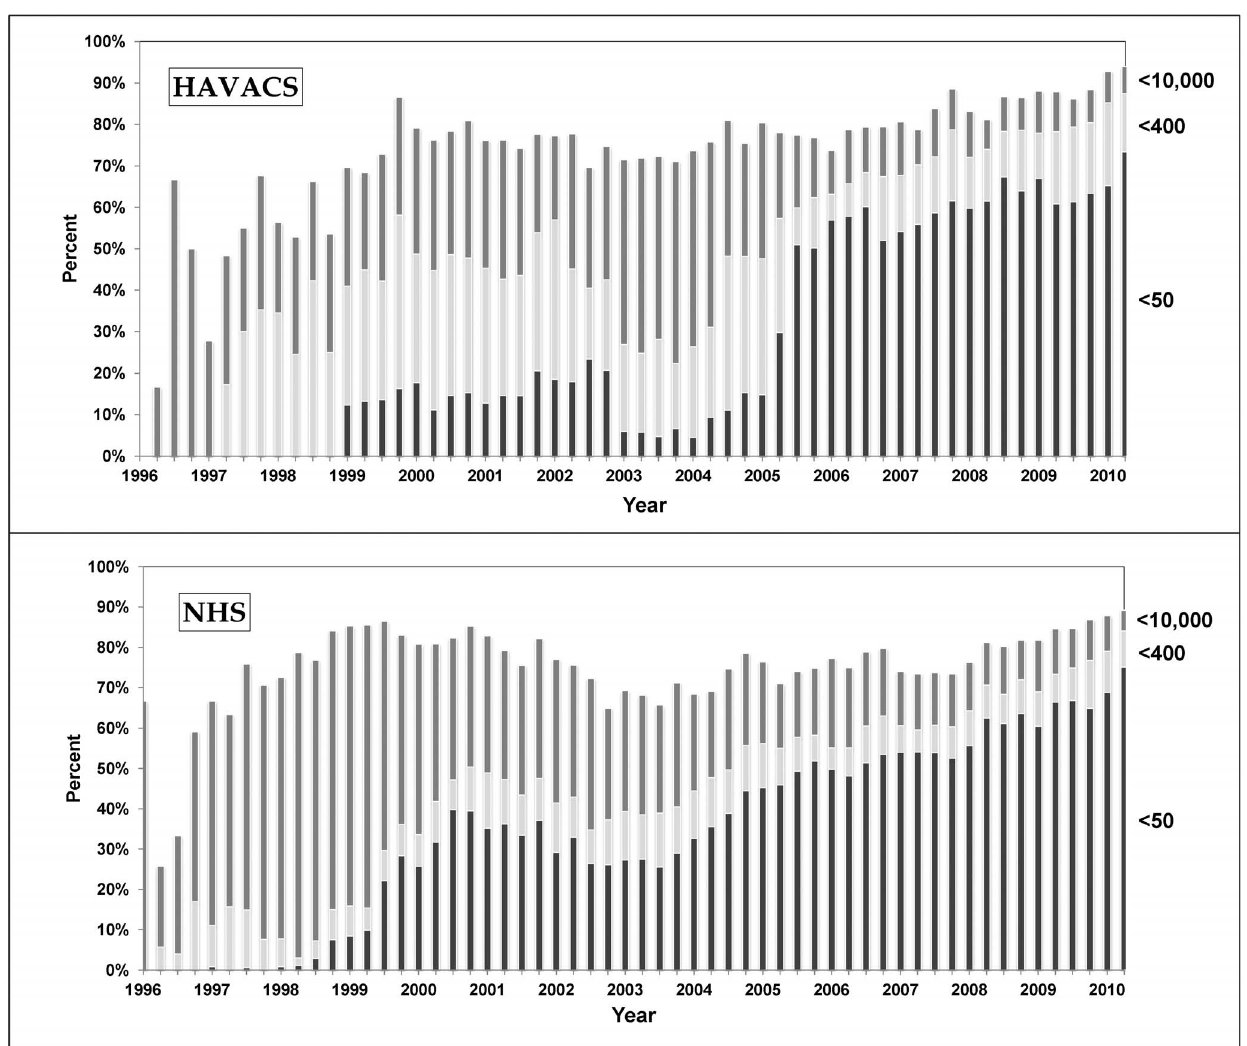
Figure 1. Quarterly HIV viral load distributions within each HAART-initiating cohort from January 1, 1996 to June 30, 2010.